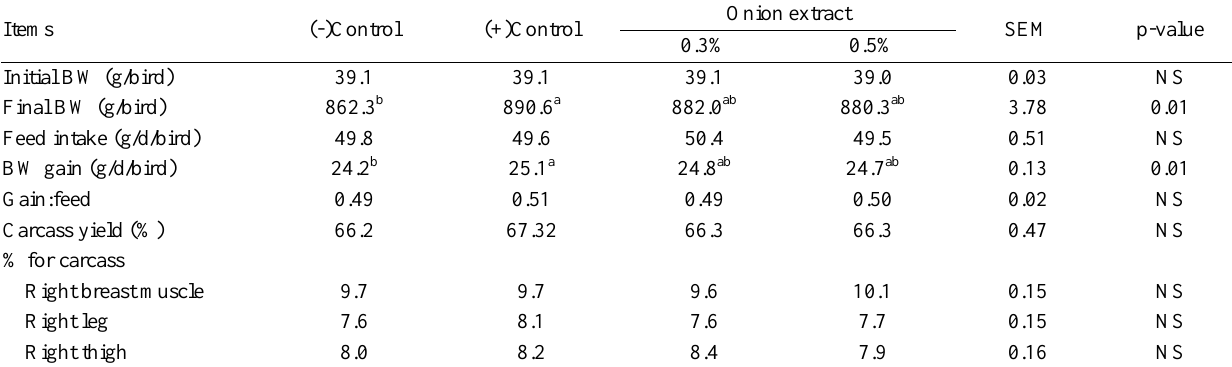
Table 2. Dietary effects of onion extract on growth performance and carcass yield of White mini broilers 1